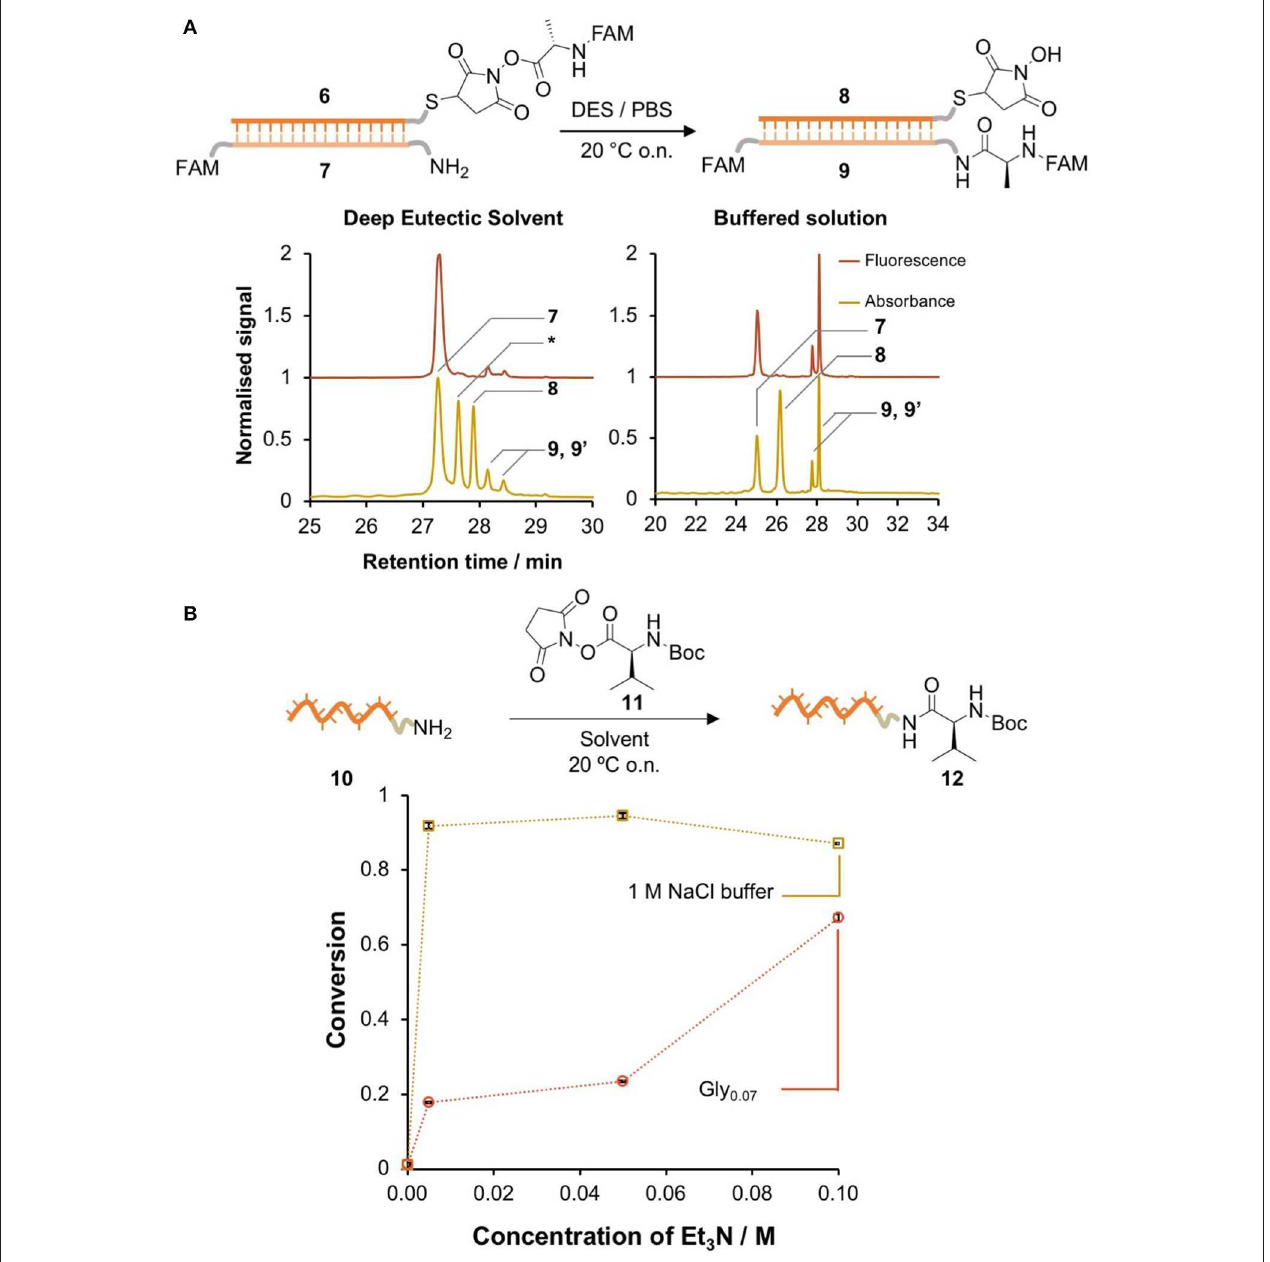
FIGURE 3 | DNA-templated formation of peptide bonds in DES. (A) Single-step DNA-templated synthesis of a peptide bond in glycholine and in PBS. The conversion was determined by HPLC integration of the signals corresponding to 7, 9, and 9’ (isomers of the product). Peaks were identified by LC-MS (Bruker AmazonX): 7 [M-H] − m/z calcd. 9337.2 found 9336.0; * DNA-SH [M-H] − m/z calcd. 10615.2 found 10599.6; 8 [M-H] − m/z calcd. 10712.0 found 10712.4; 9 and 9’ (isomers) [M-H] − m/z calcd. 9723.6 (B) comparison of the reactivity of an amine-labeled DNA (10) in the presence of an excess of activated ester (11) in Gly 0.07 / Et 3 N and 1M NaCl (aq)/Et 3 N. The conversion was determined by HPLC integration of the signals corresponding to 10 and 12. Peaks were identified by LC-MS (Bruker AmazonX): 10 [M-H] − m/z calcd. 3897.7 found 3898.6; 11 [M-H] − m/z calcd. 4096.8 found 4097.7. Error bars correspond to the standard deviation over multiple integration events.